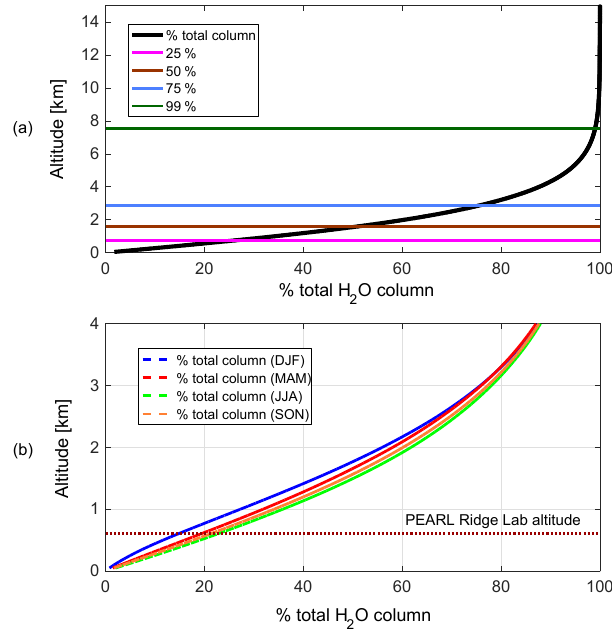
Figure 2. Distribution of water vapour above Eureka from ra- diosonde profiles (August 2006 to December 2015). The black line illustrates how much of the total column is beneath a given altitude. One fifth of the water vapour total column is typically located be- neath 610m, the altitude of the PEARL Ridge Lab (noted by the dotted dark red line). The horizontal lines show the altitudes at which each quartile is passed. (a) Altitudes up to 15km. (b) The mean distribution of the water vapour total column up in the lower troposphere by